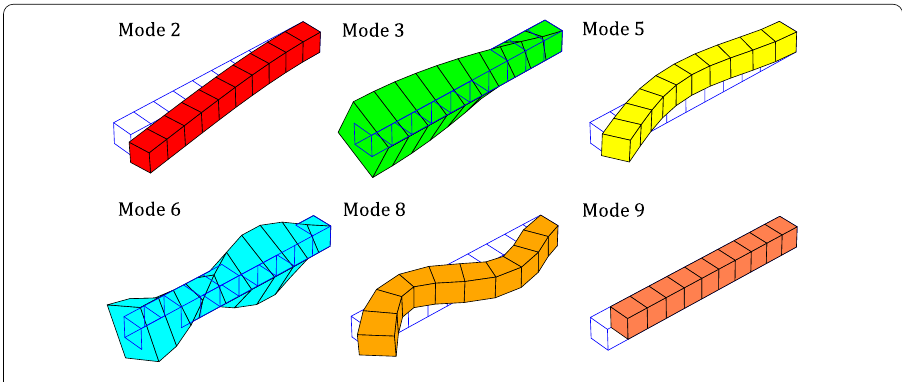
Fig. 7 Mode shapes of the cantilever beam obtained with the proposed solid element